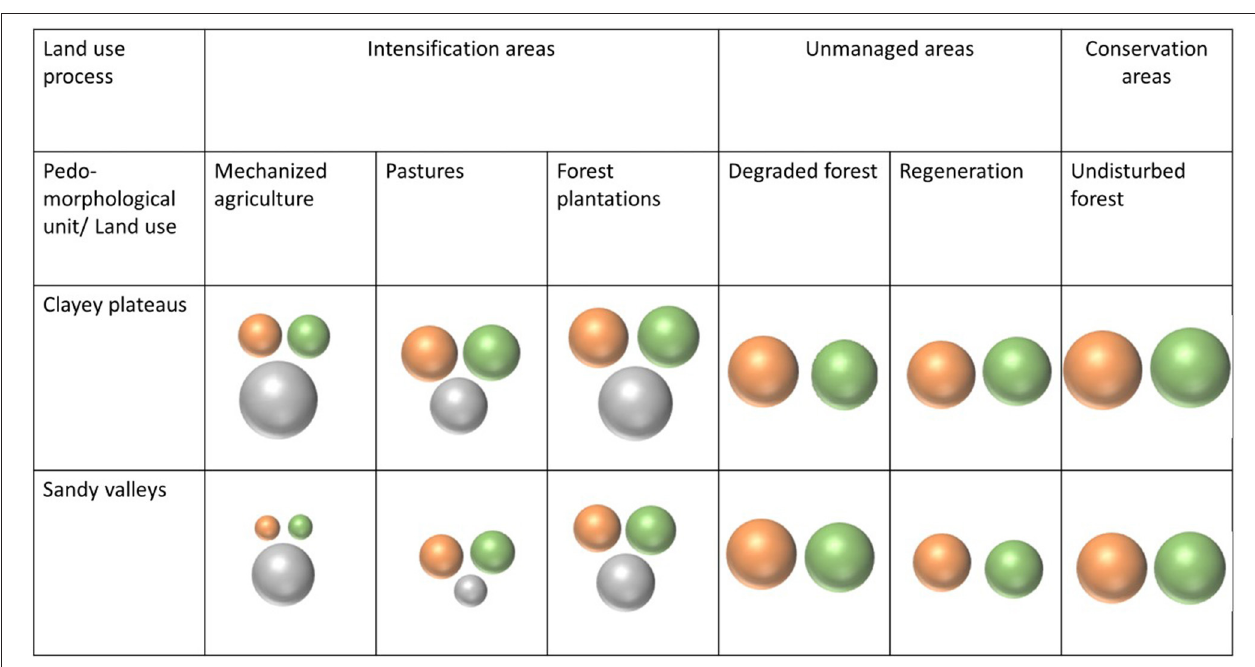
FIGURE 3 | Supply matrix of ecosystem services in Paragominas for different pedo-morphological units and land uses associated with different land use processes. Supply of carbon storage (brown), habitat for biodiversity (green), and commodity production (gray) are indicated by bubbles, and bubble size is indicative for relative supply level. This analysis is informed by a literature review ( Tables 1 , 2 ) and personal